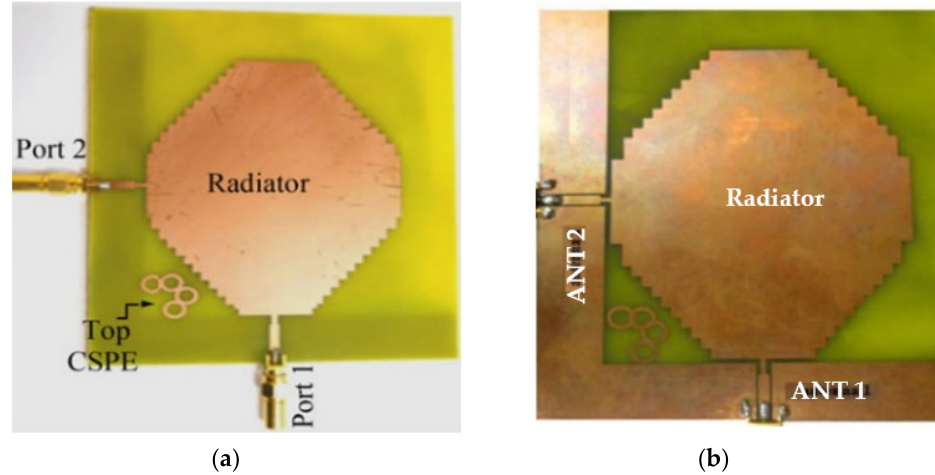
Figure 6. ( a ) Fabricated prototype with CPSE [61] ( b ) CPW-fed fabricated prototype with CPSE [62].